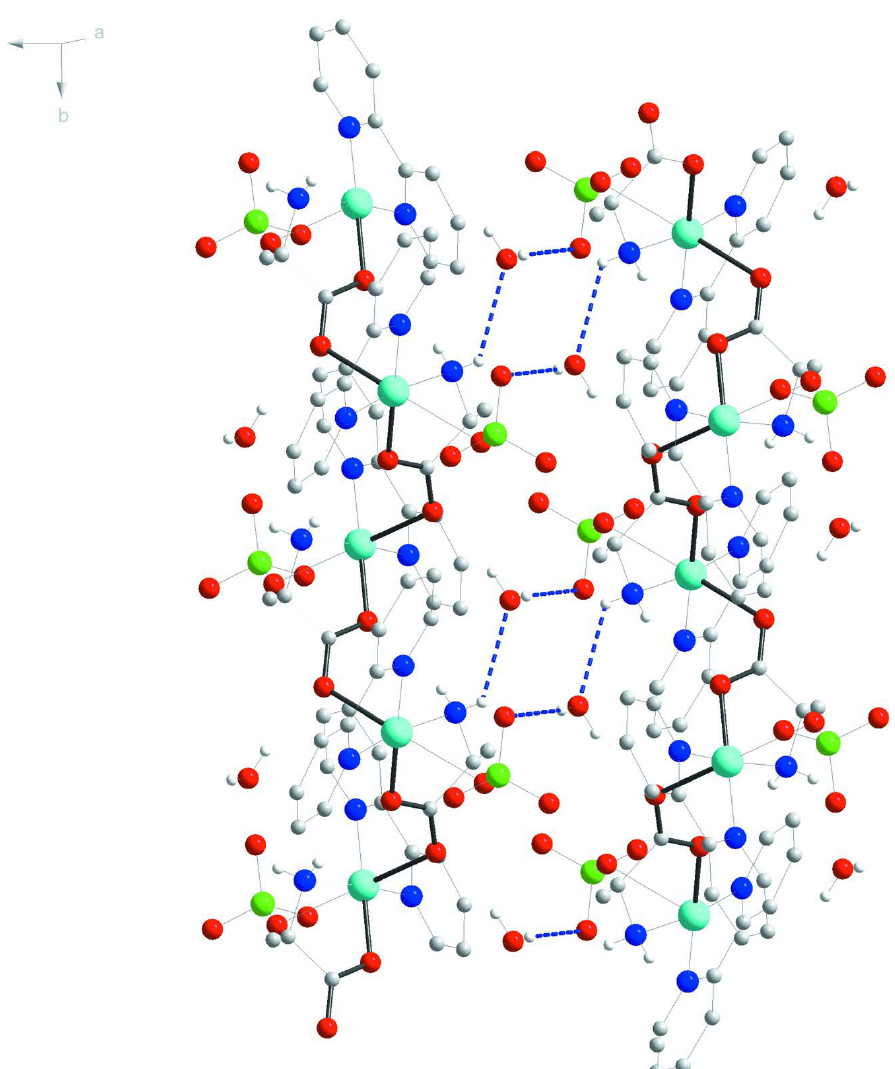
Figure 3 Supramolecular assembly at the secondary level formed by H-bond formation. The single strand chain is represented with thick bonds whereas the H-bonds are represented by blue dashed lines. For clarity only hydrogens (shown in white) involved in intermolecular associations are